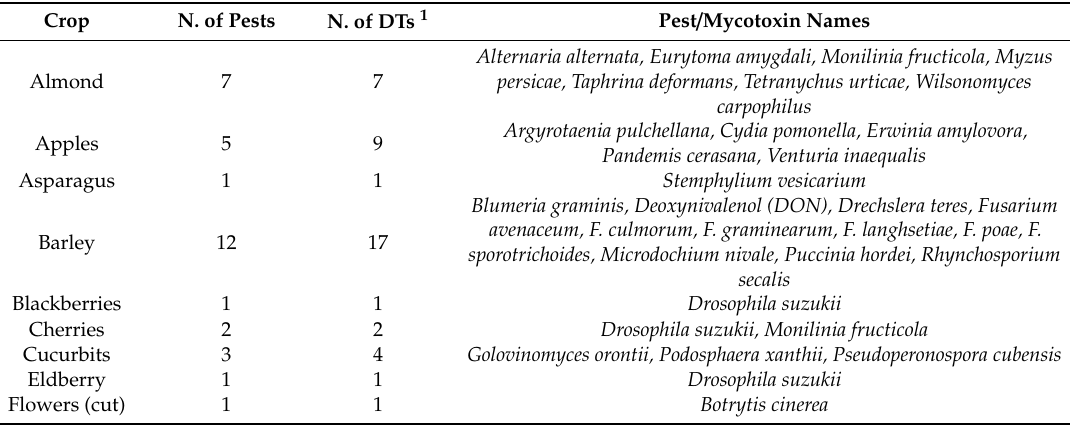
Table A1. List of decision tools implemented in the